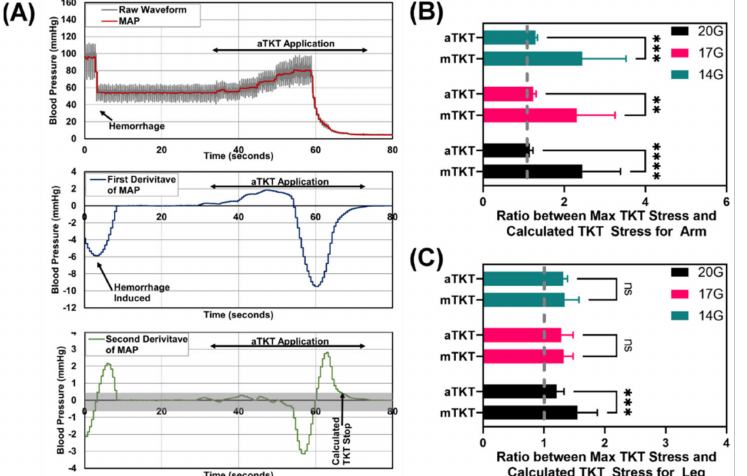
Figure 7. Analysis of Tourniquet overtightening. ( A ) Representative MAP and its first and second derivatives vs. time during aTKT application. ( B ) Ratio between the required TKT application stress at the theoretical bleed stop and maximum TKT application stress for the arm test platform for three hemorrhage rates ( n = 12). ( C ) Ratio between the required TKT application stress at the theoretical bleed stop and maximum TKT application stress for the leg test platform for three hemorrhage rates ( n = 12). Significant differences between overtightening ratios were determined by two-way ANOVA, post-hoc Sidak’s test (**, p < 0.01; ***, p < 0.005; ****, p < 0.0001; ns = not significant). Error bars denote standard